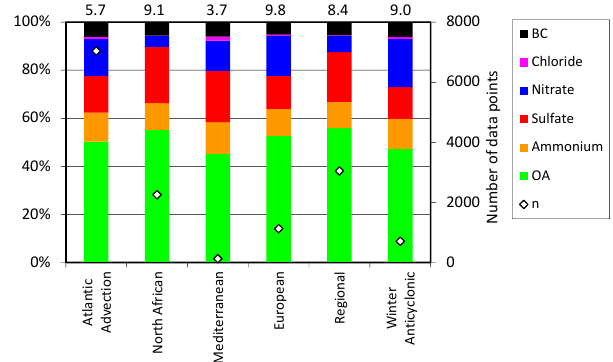
Figure 6. Relative chemical composition of submicron aerosol as a function of the type of scenario. The numbers at the top of each bar represent the average concentration for each type of scenario. n is the number of data points for each type of scenario (right